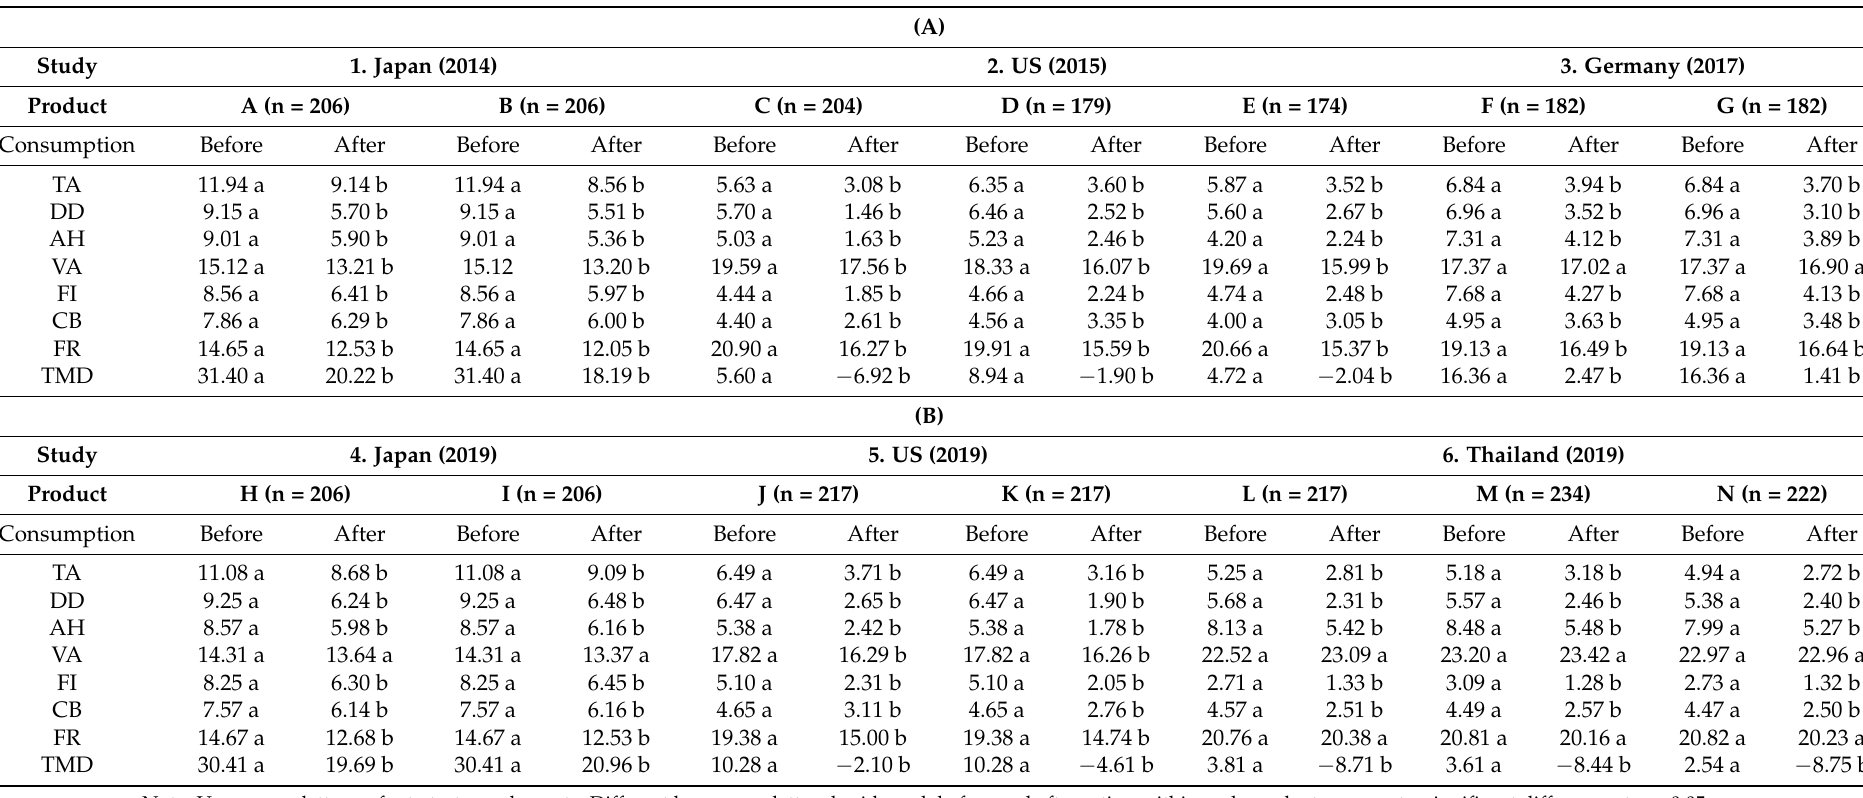
Table 6. ( A ). Profile of mood states (POMS) before vs. after product consumption by product. ( B ). Profile of mood states (POMS) before vs. after product consumption by product.